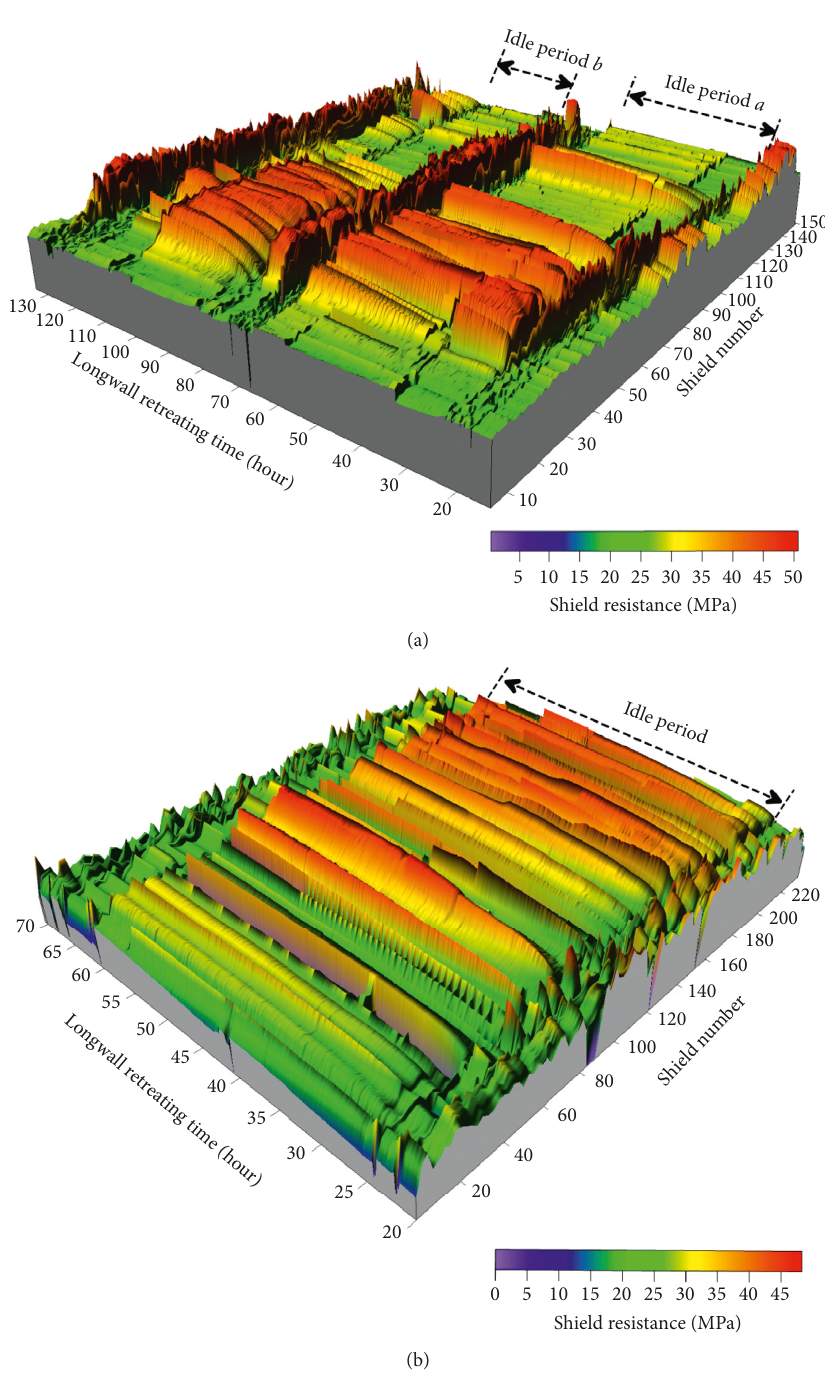
Figure 6: Change of shield resistance with longwall retreating time. (a) Two long idle periods in Panel LW22304 of Daliuta mine with hard roof. (b) One idle period in panel LW63 of Cumberland mine with medium-weak